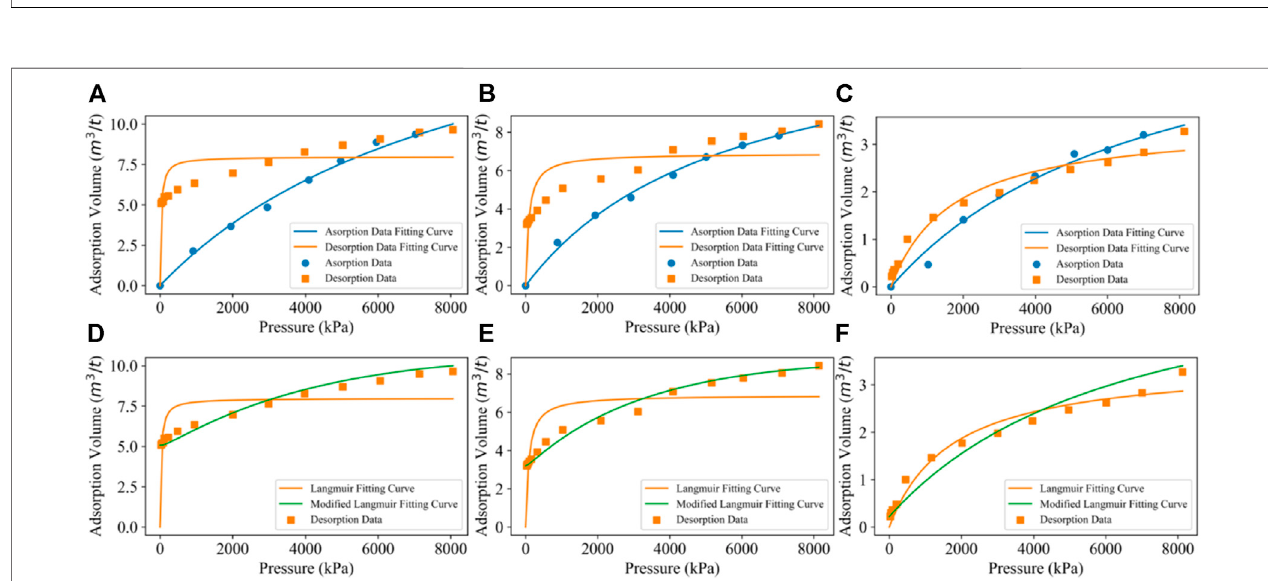
FIGURE 3 | Experiment data fitting: fi tting by the Langmuir isotherm: (A) dry coal sample, (B) moisture-equilibrated coal sample, and (C) moisture-saturated coal. Fitting desorption data by modi fi ed Langmuir isotherm: (D) dry coal sample, (E) moisture-equilibrated coal sample, and (F) moisture-saturated coal.